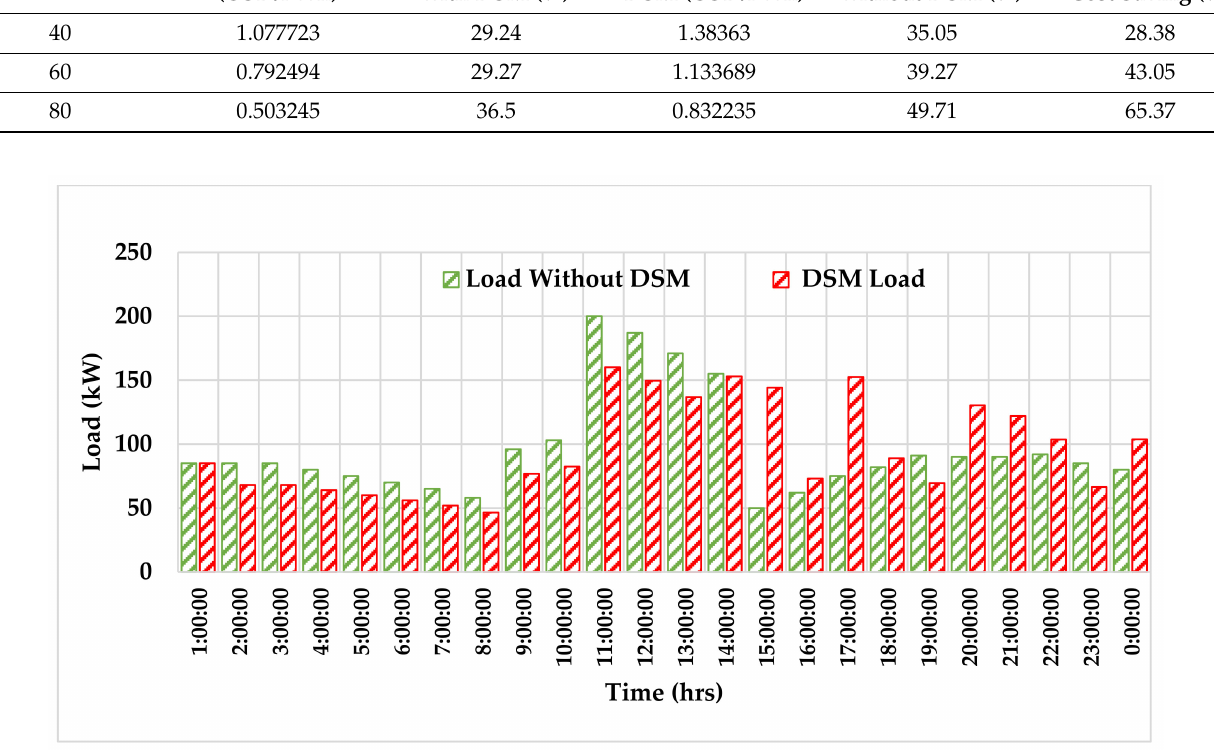
Figure 15. Daily load profile of AEO at 40% REF.